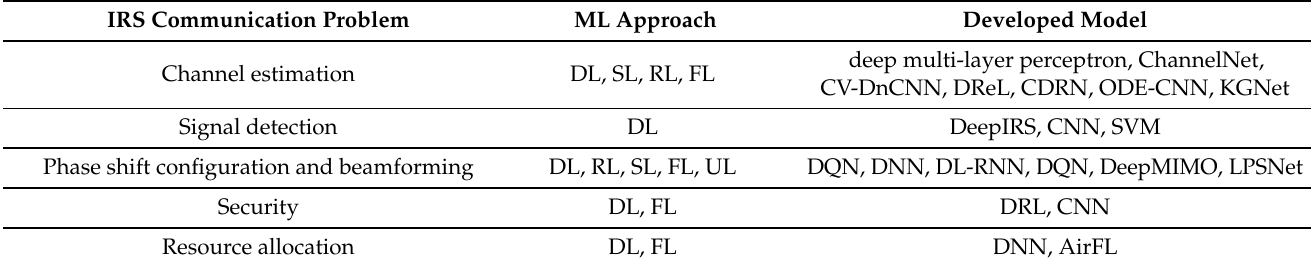
Table 2. Machine learning approaches for IRS-based